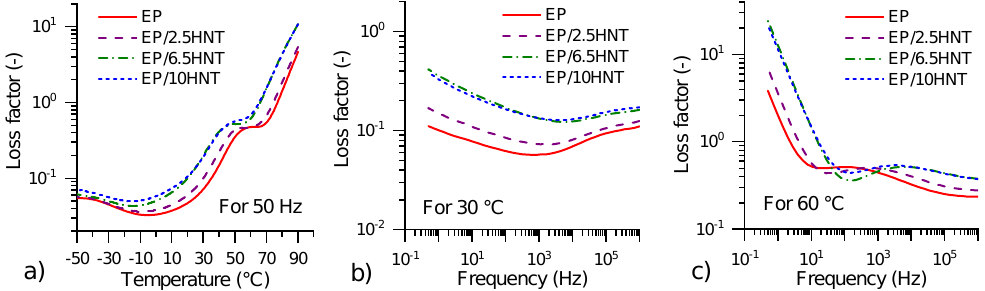
Figure 7. Loss factor characteristics: ( a ) Temperature dependencies at 50 Hz, ( b ) frequency dependencies at 30 ◦ C, and ( c ) frequency dependencies at 60 ◦ C for all tested